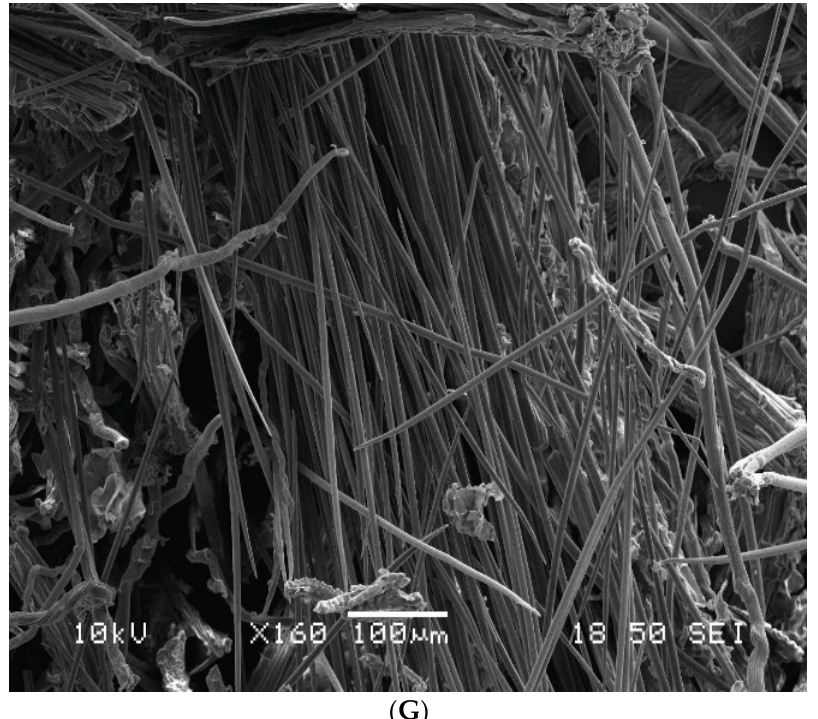
Figure 3. Scanning electron microscopy images of Miscanthus spp. ( A , B ) raw milled samples (cultivar C), ( C , D ) after 1% sulphuric acid pre-treatment (cultivar B); ( E ) after degradation of cellulose and hemicellulose in Klason lignin analysis (cultivar C); ( F ) after lignin extraction in cellulose measurement (cultivar B); ( G ) after lignin and hemicellulose extracted in cellulose measurement (cultivar B).